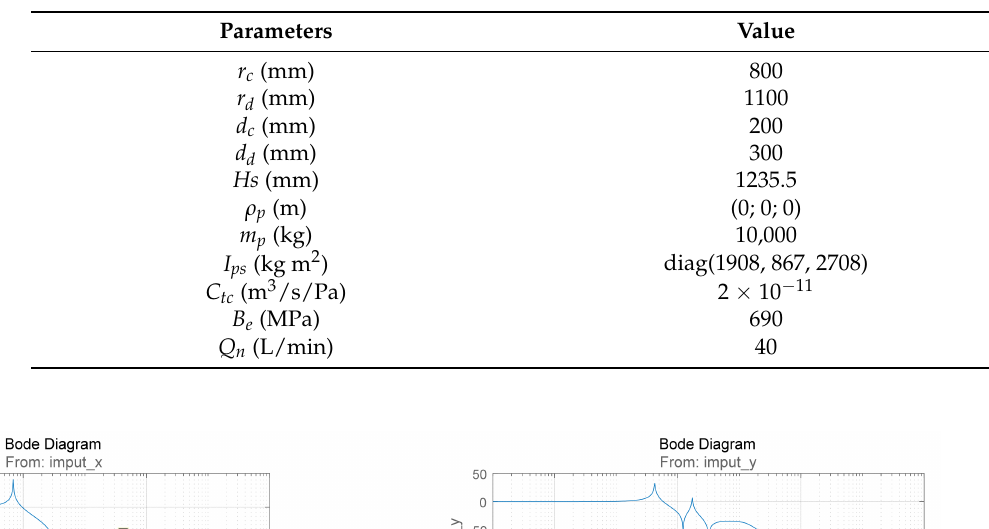
Table 1. Technical parameters of parallel